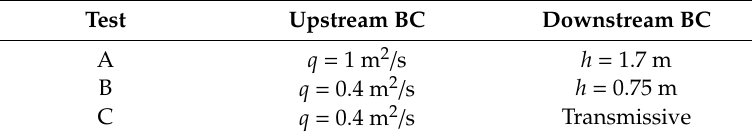
Table 1. Boundary conditions for three test